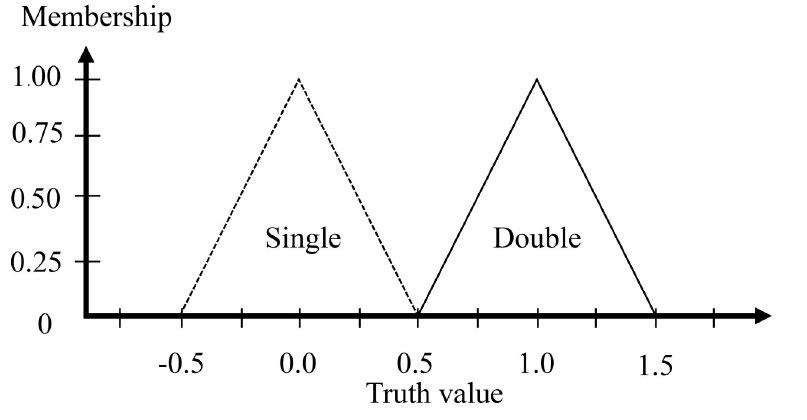
Fig 10. Output membership functions of the truth value.